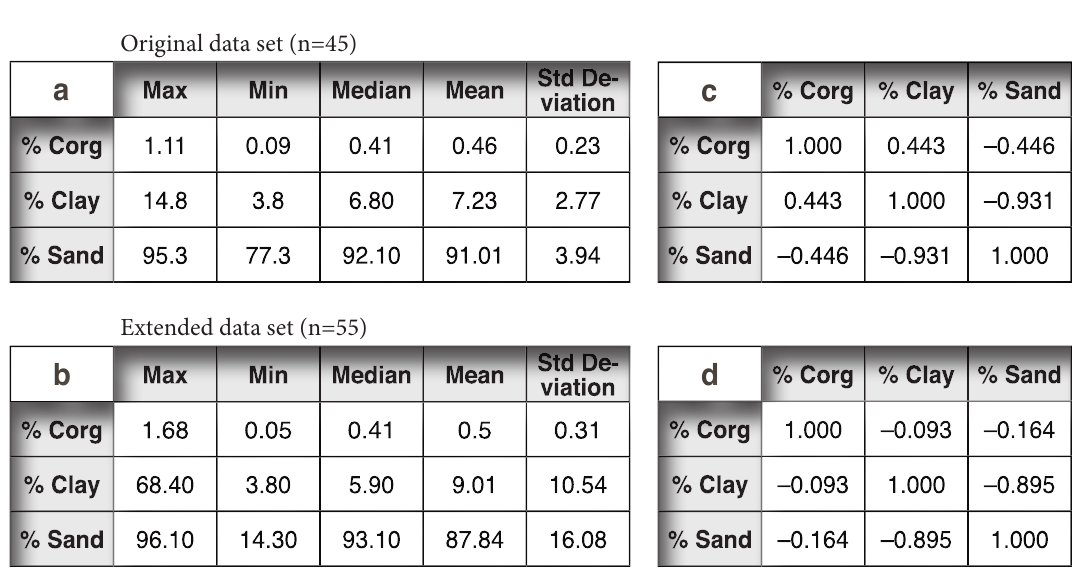
Figure 2. Descriptive statistics for the original ( a ) and the extended dataset ( b ): Min, Max, Mean, Median, and Std Deviation of the used soil properties % organic carbon (Corg), % clay, and % sand, and the cross correlations for the the original ( c ) and the extended dataset ( d